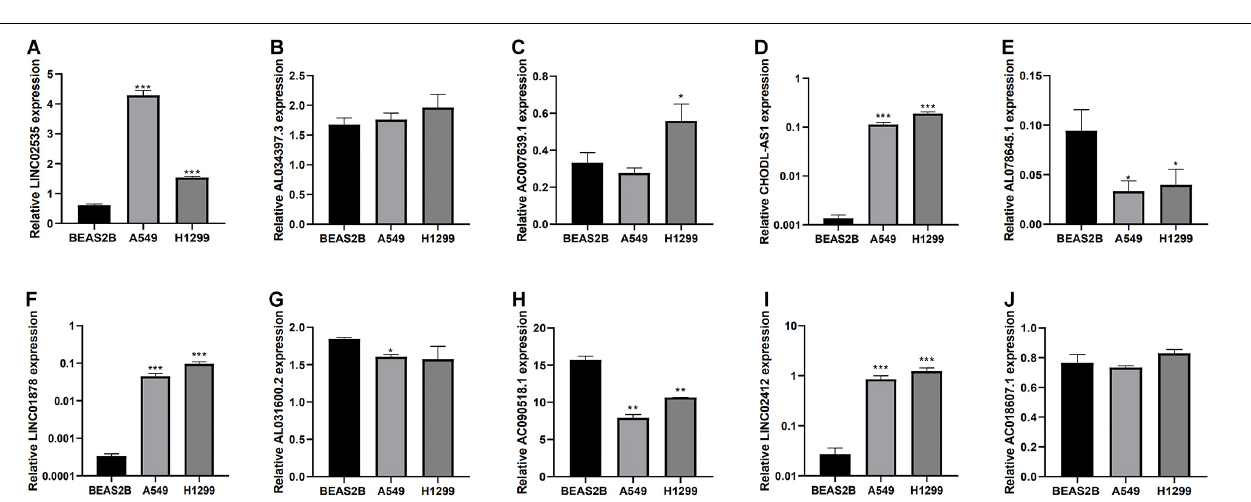
FIGURE 7 | Analyzing differentially expressed genes related to EMT between the high-risk group and the low-risk groups. (A–G) Differentially expressed genes related to the immune response between the high-risk group and the low-risk group. * P < 0.05, ** P < 0.01, and *** P < 0.001.